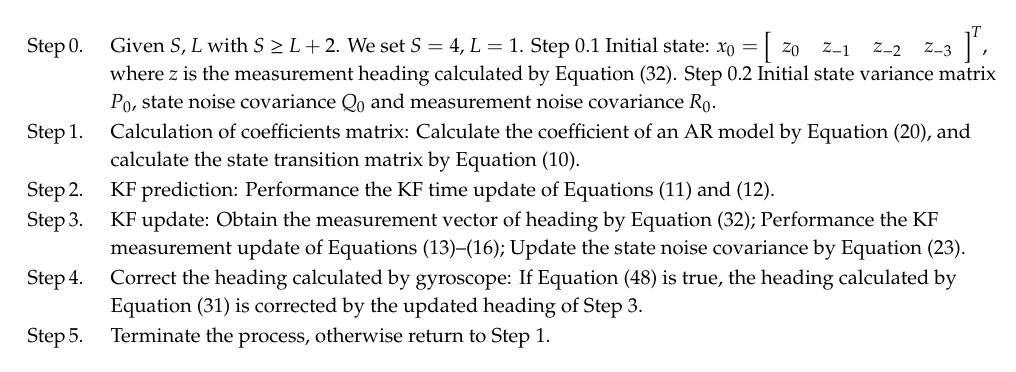
Algorithm 1 : The heading estimation with KF based on AR